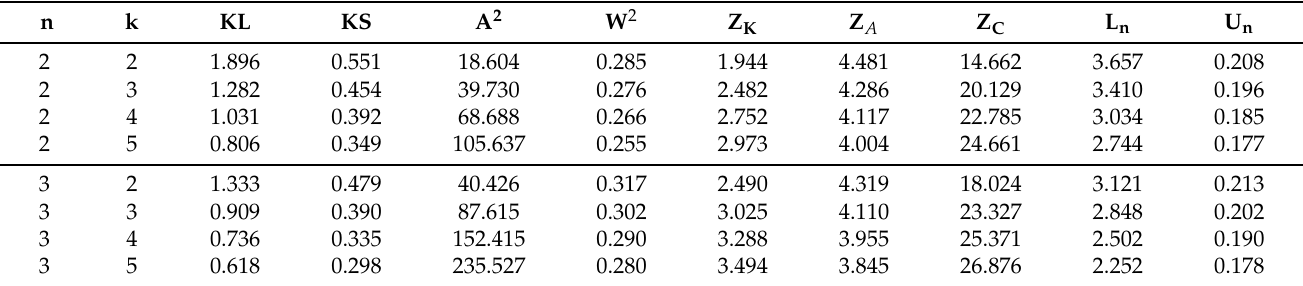
Table 1. The CV values of different tests of WGQLD for some values of ( n , k ) in RSS, at significance level of γ =